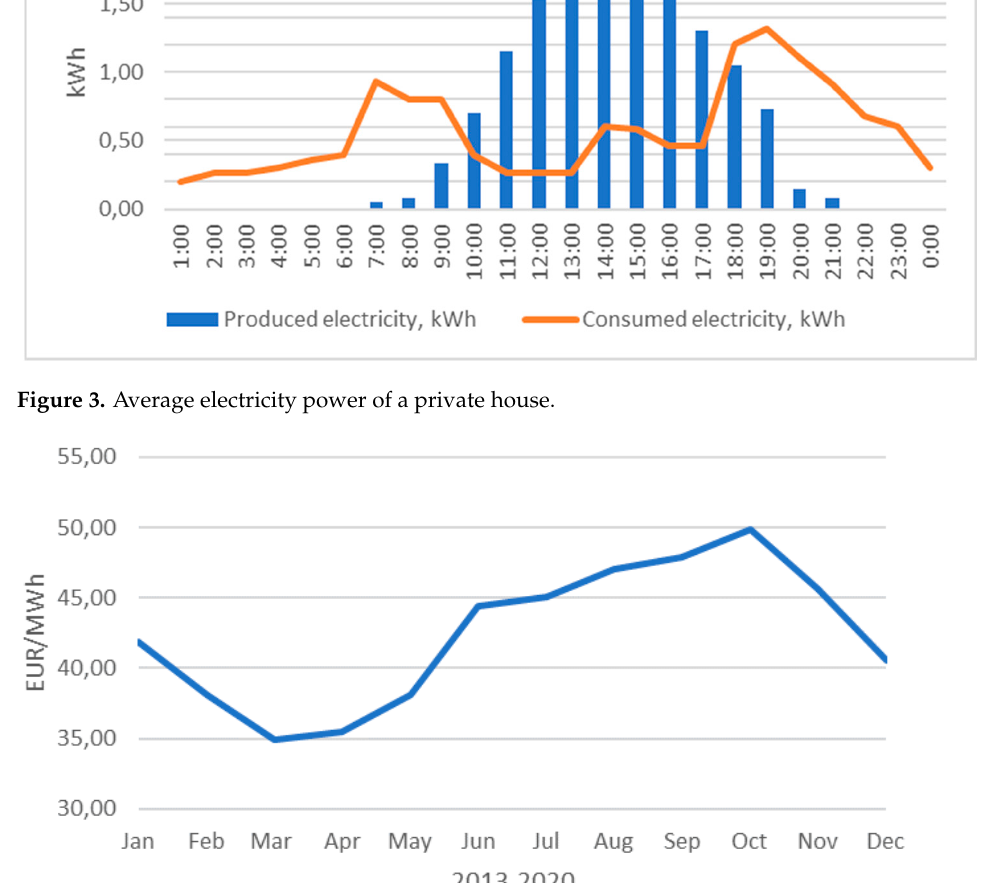
Figure 4. Dynamics of Nord Pool average Elspot prices.